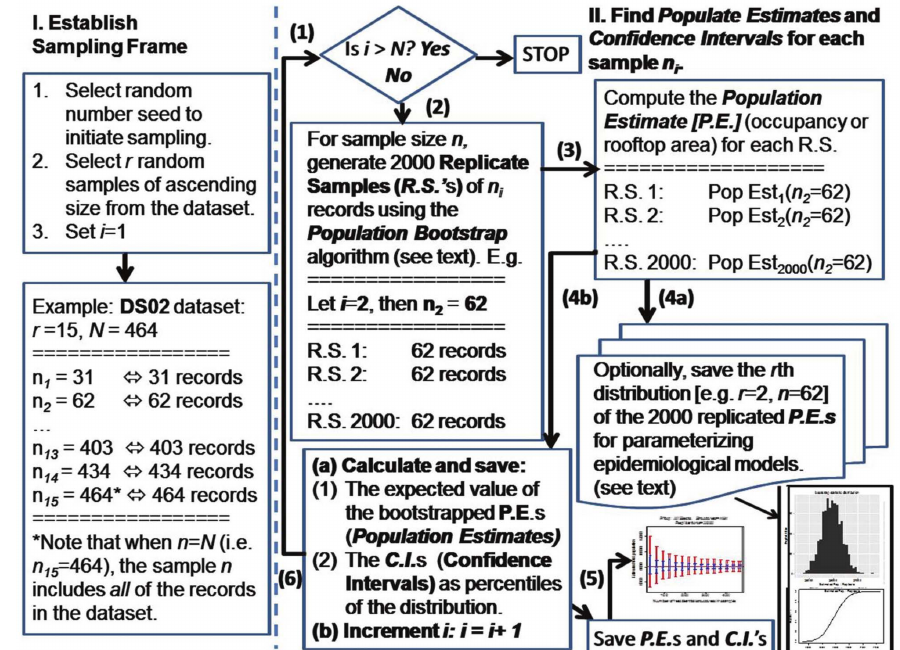
Figure 3. Flowchart for population bootstrap.